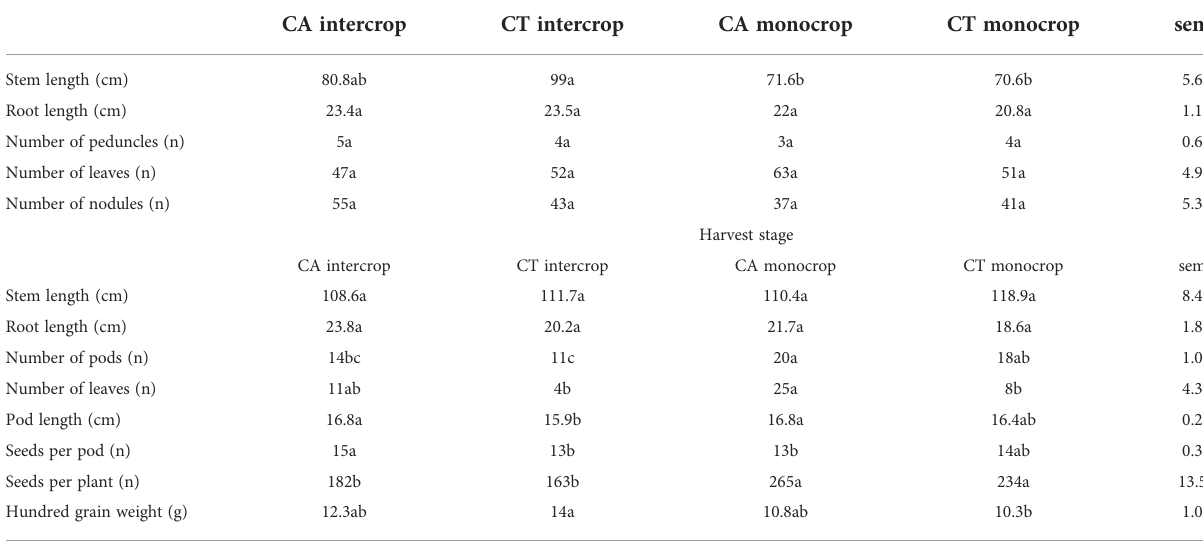
TABLE 2 Cowpes phenological characteristics at fl owering and harvest stages.